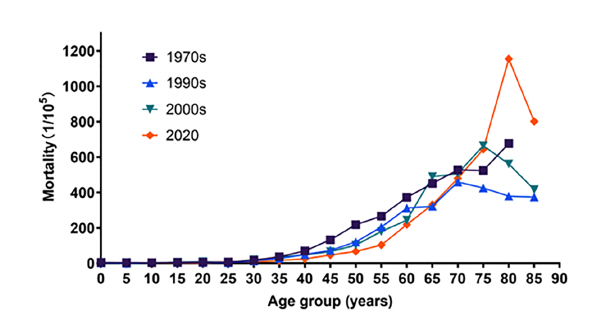
FIGURE 6 Age-speci fi c mortality rates and trends in male, trends of Chi-square of the 1970s, the 1990s, the 2000s, and 2020 were 28,189.370, 3,971.809, 4,486.643, and 27,102.434, respectively. All P-values were less than 0.05.